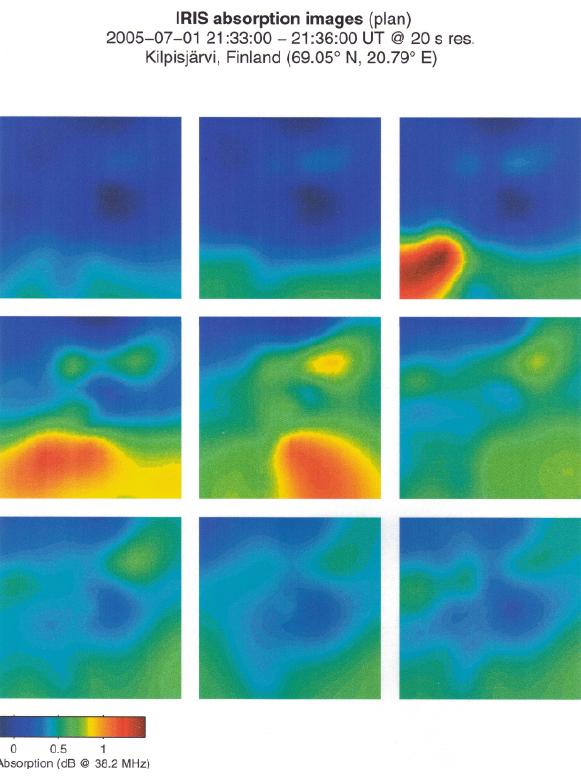
Fig. 8. Motion of the evening spike as observed by the Kilpisj¨arvi imaging riometer. These images are based on interpolation between the 90-km intersections of the 49 beams.